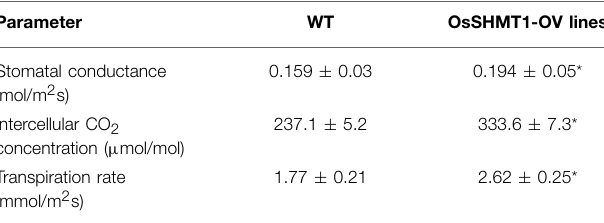
TABLE 3 | Comparison of photosynthesis parameters between WT and OsSHMT1-OV rice leaves ( n = 15 ), the asterisks shows significantly different between the OsSHMT1-OV and wild type at P ≤ 0